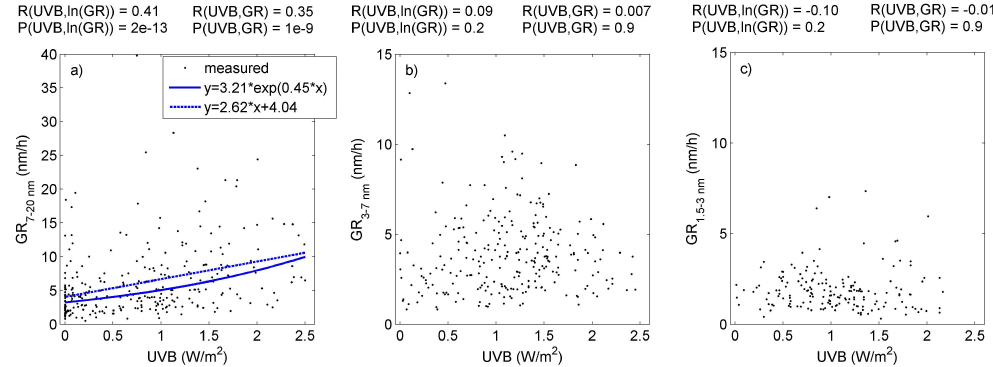
Fig. 8. Growth rate (GR) of particles in the size ranges (a) 7–20nm, (b) 3–7nm and (c) 1.5–3nm as a function of UVB radiation intensity (UVB) and the correlation coefficients ( R ) and p-values between UVB and GR and natural logarithm of GR. For size range 7–20nm also shown are the fitted lines GR= a 2 · exp( b 2 · UVB) and GR= b 3 · UVB+ a 3 .